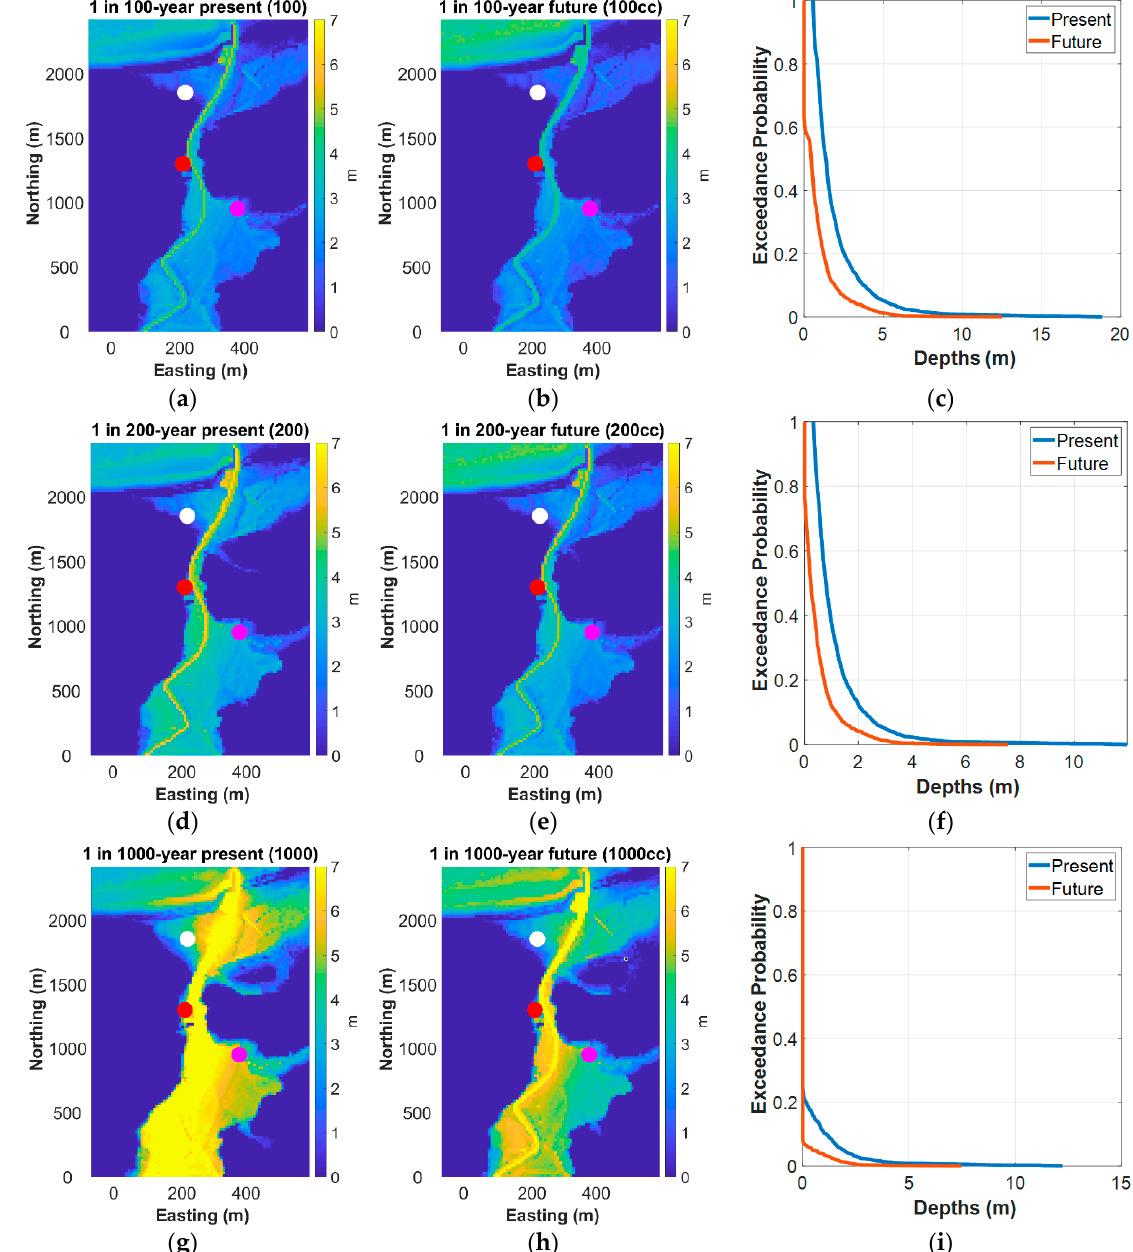
Figure 9. The flood of three different return period scenarios under present conditions: ( a ) 1 in 100 return period; ( d ) 1 in 200 return period; ( g ) 1 in 1000 return period and under future scenarios with climate change (CC): ( b ) 1 in 100 return period; ( e ) 1 in 200 return period; ( h ) 1 in 1000 return period. The main electricity transformers Node 1, Node 6, and Node 14 are marked as red, magenta, and white solid circles, respectively) and the exceedance of probabilistic distribution of flooded depths at these three most vulnerable electricity transformers (Nodes): ( c ) Node 1; ( f ) Node 6; ( i ) Node 14. Most of these sewage system facilities are located at the west side of the river and experience a similar trend with that in the electricity sector: an increase in the CDF of flooding depths at each site and, subsequently, a decrease in the probability of failure of each facility (Figure 10). However, it is not just these facilities themselves that are under